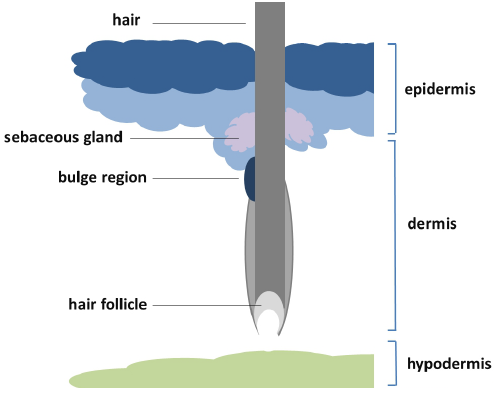
Figure 1. A cross section of the human skin. Epidermal stem cells are found in the basal layer and in the bulge